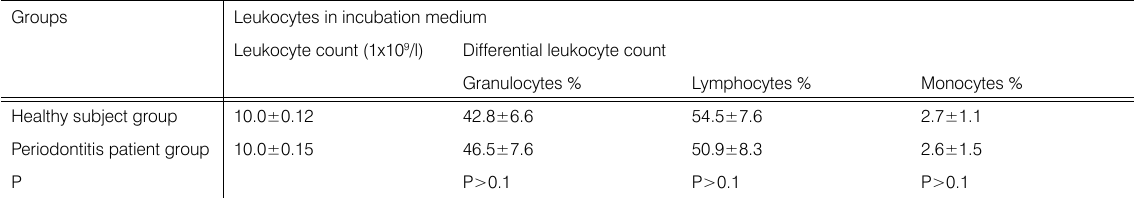
Table 4. Leukocyte count and percentage distribution in incubation medium